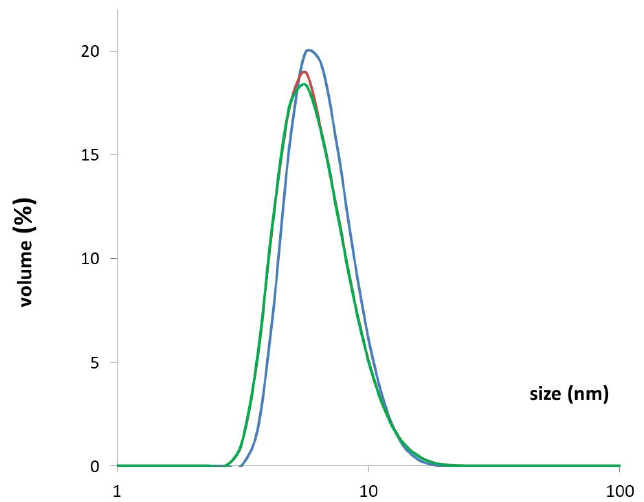
Figure 4. DLS measurement results for rhPEPD as the averages of three independent experiments for each protein sample. Measurement immediately after the two-stage protein purification (blue line), after 4 hours of storage at room temperature (red line), and after freezing and thawing the preparation (green line).